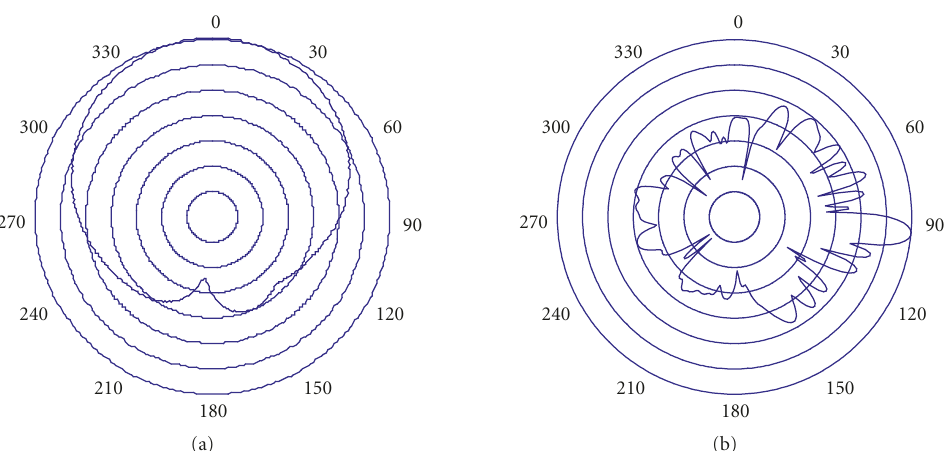
Figure 3: Antenna horizontal (a) and vertical (b) radiation patterns. Antenna gain 17.6 dBi, beamwidth 65 degrees, and electrical downtilt 5